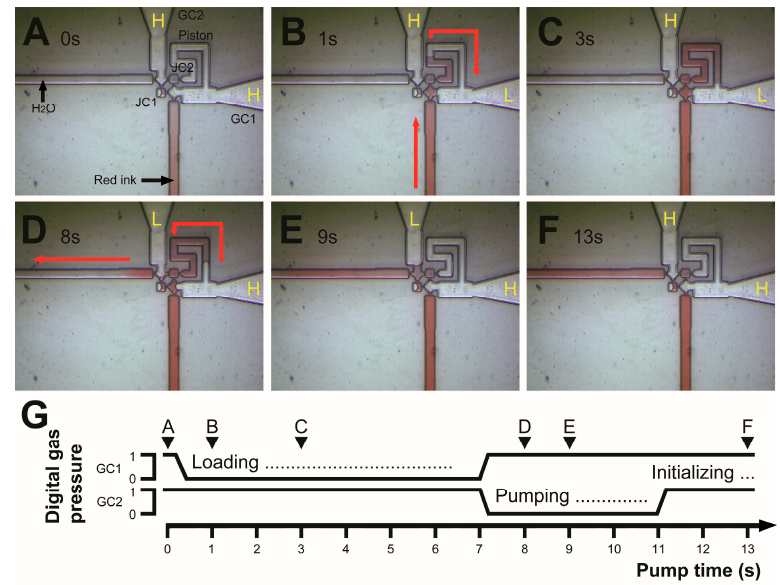
Figure 3. A 13 s pumping cycle controlled by two-way digital commands. After the pump is initialized (( A ) 0 s), a pump cycle starts loading and red ink enters into the piston through JC2 (( B ) 1 s), red arrows; (( C ) 3 s). At 7 s, the pump starts pumping and red ink in the piston is pushed into the output channel (( D ) 8 s), red arrows; (( E ) 9 s). At 11 s, the pump is reset by a initializing process and ready for next pump cycle (( F ) 13 s). The three basic processes (loading, pumping, and initializing) of a pump cycle are controlled by digital gas pressure. ( G ) 1 represents high pressure of 4.5 kPa and 0 represents low pressure of 2.8 kPa applied on GC1 and GC2). GC1: Gas control 1; GC2: Gas control 2; H: High pressure; L: Low pressure; JC1: Joint chamber 1; JC2: Joint chamber 2.